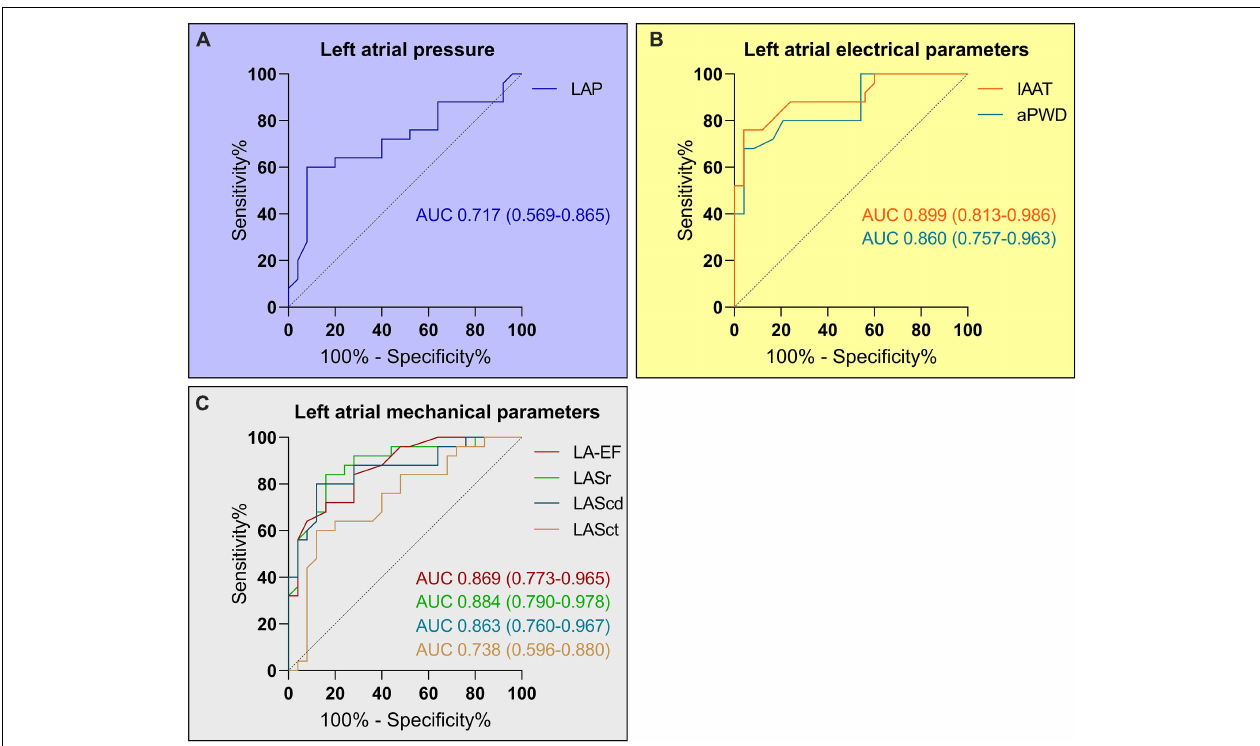
FIGURE 3 | Diagnosis of relevant atrial cardiomyopathy (ACM) based on left atrial pressure (LAP), left atrial electrical and mechanical parameters. Receiver-operating curve analysis determined a LAP ≥ 12.4 mmHg as predictor for relevant ACM with a sensitivity of 72% and a specificity of 60% (A) . The corresponding values for the left atrial electrical parameters (B) were ≥ 143 ms (sensitivity 84% and specificity 80%) for the invasive atrial activation time (IAAT) and ≥ 153 ms (sensitivity 80% and specificity 79%) for the amplified p-wave duration (aPWD). The values for the left atrial mechanical parameters (C) were ≤ 33% for LA-EF (sensitivity 84% and specificity 72%), ≤ 23% for LASr (sensitivity 84% and specificity 84%), ≤ 13.4% for LAScd (sensitivity 88% and specificity 80%), and ≤ 6.8% for LASct (sensitivity 80% and specificity